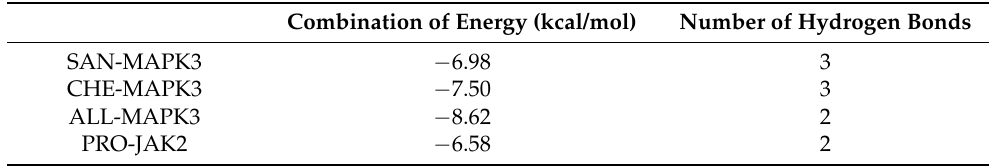
Table 4. Molecular docking